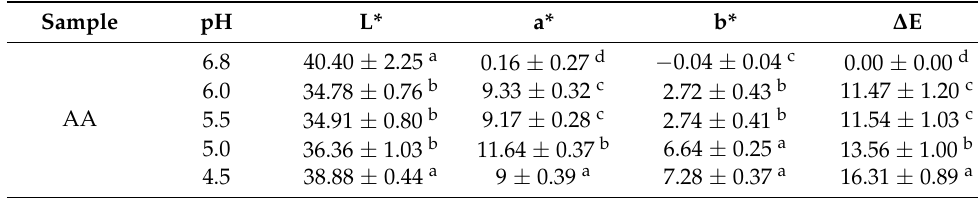
Figure 3. Photographs of the AA sensors with anthocyanins showing the colorimetric response to lactic acid at different pH levels. Table 3. Total color change values for the AA colorimetric